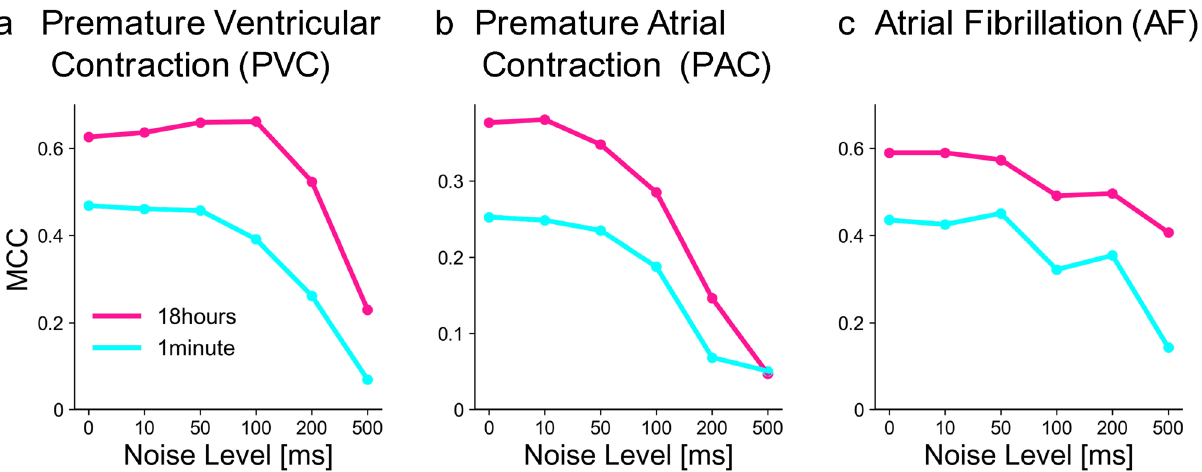
Figure 6. The MCCs for the combination method applied to recording duration of 1 minute and 18 hours. ( a ) PVC, ( b ) PAC, and ( c ) AF. Original pulse times were jittered with Gaussian noises of the standard deviation of 10, 50, 100, 200, and 500